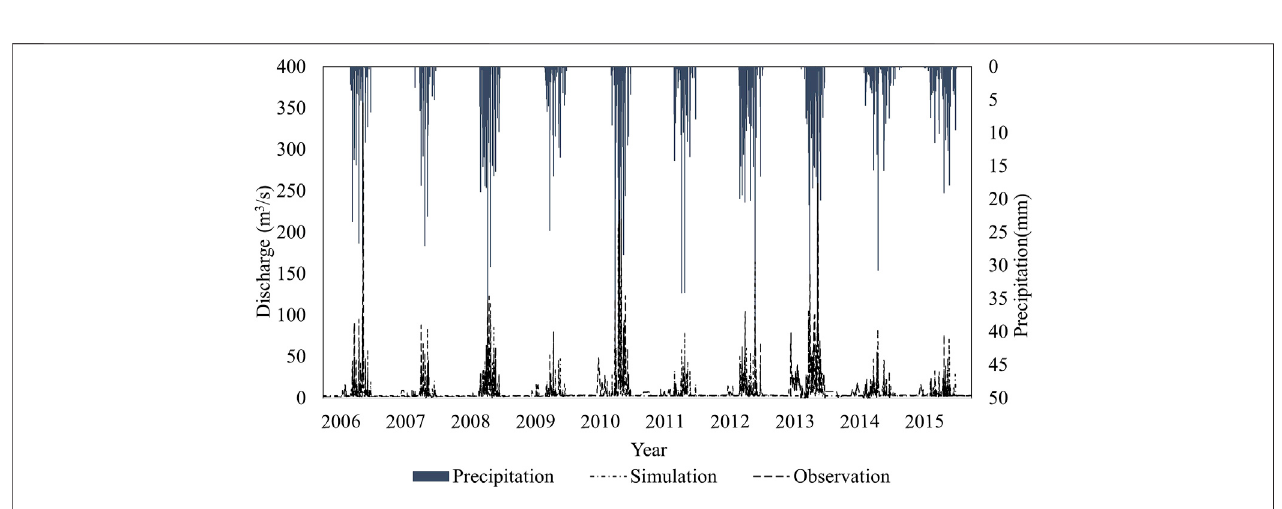
FIGURE 6 | The results of the daily model for the XAJ model from 2006 to